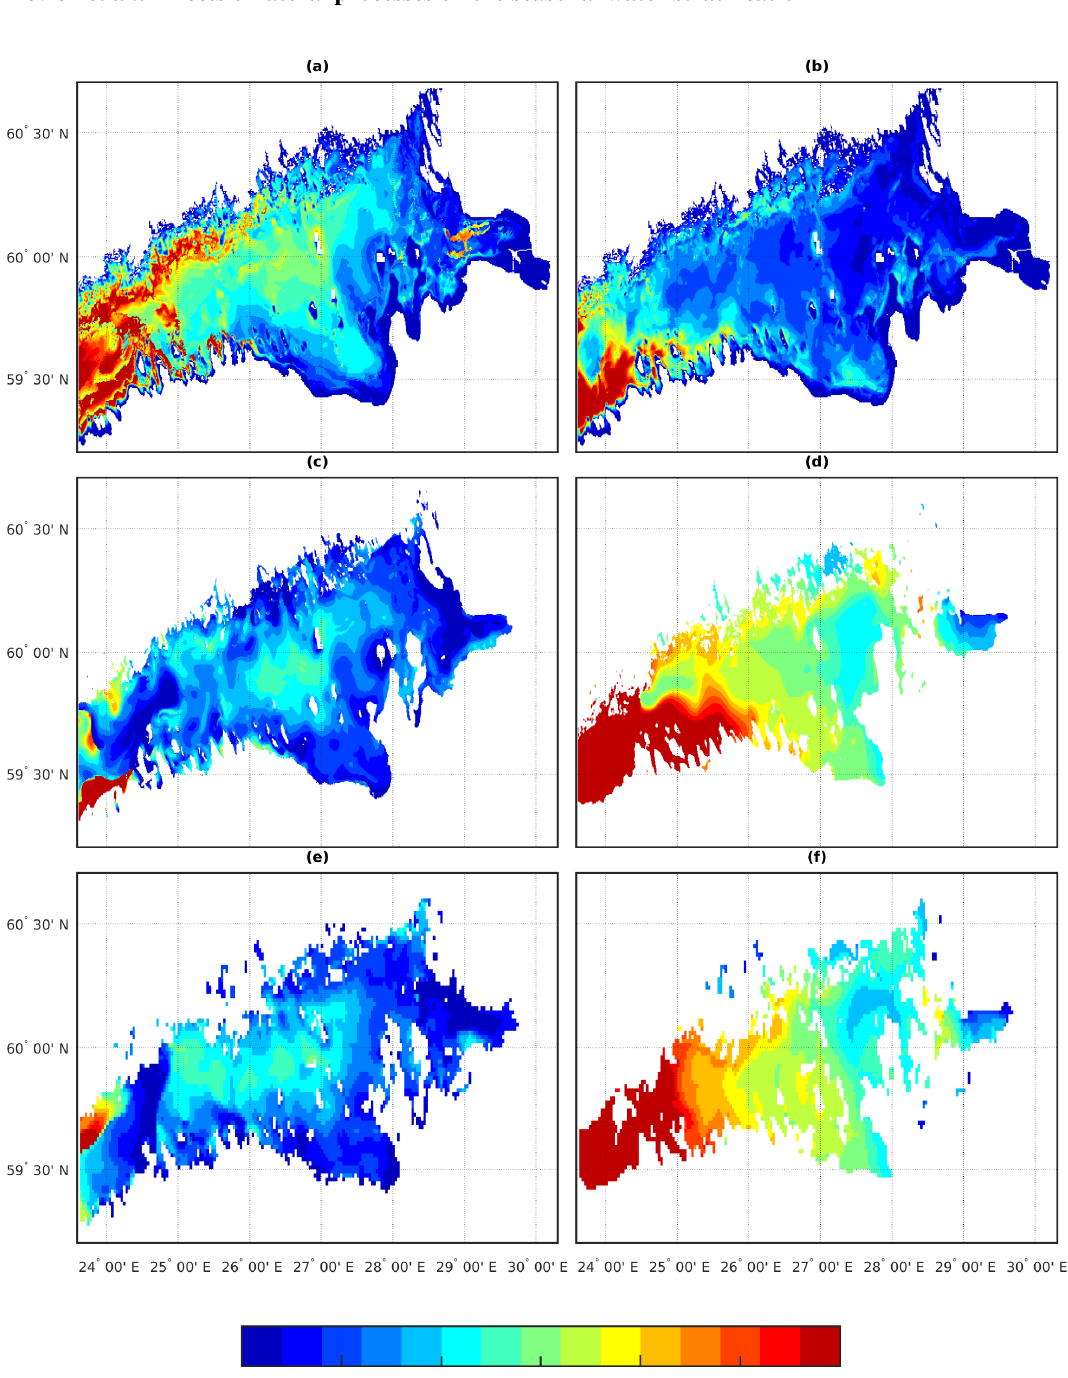
Figure 7. Depth of isotherm 3.5 ◦ C and turbocline depth for the periods: left column 11–30 May 2011, right column 1 June–28 July 2011. (a, b) Maximum turbocline depth, model 0.5km resolution; (c, d) isotherm 3.5 ◦ C depth model 0.5km; (e, f) isotherm 3.5 ◦ C depth model